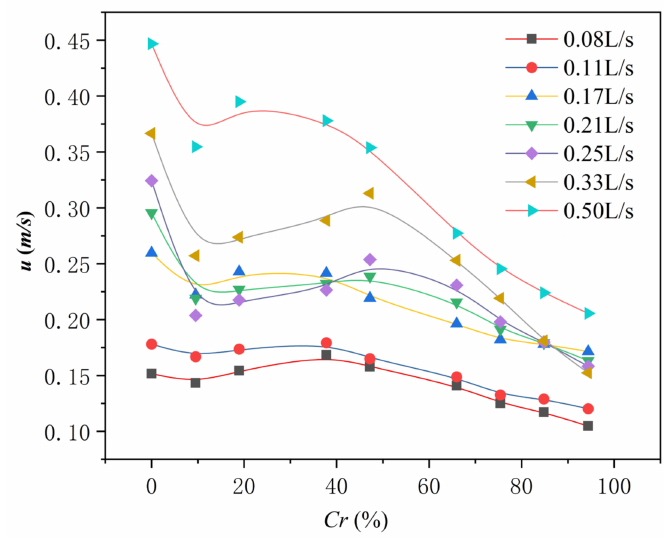
Figure 5. Relationship between mean velocity (u ) and degree of coverage ( Cr ).